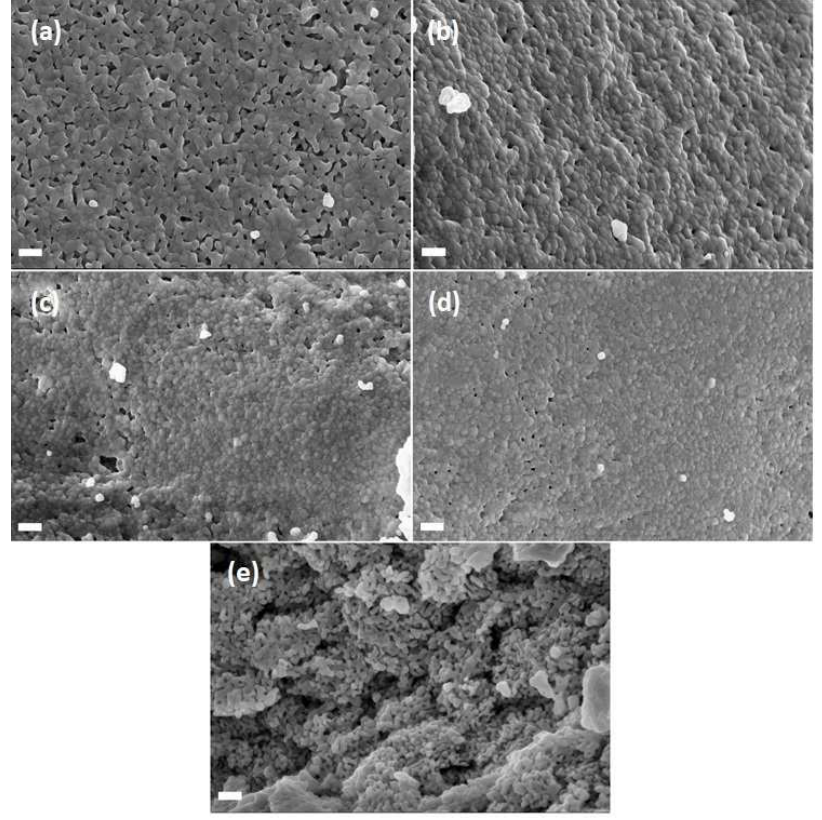
Figure 3. FE-SEM images of ( a ) Nb 2 O 5 , Mn-doped Nb 2 O 5 ( b ) 1.0, ( c ) 2.5, ( d ) 5.0 and ( e ) 10.0 wt.% samples, submitted at 700 ◦ C. Guide bar: 200 nm; Mag = 80.00